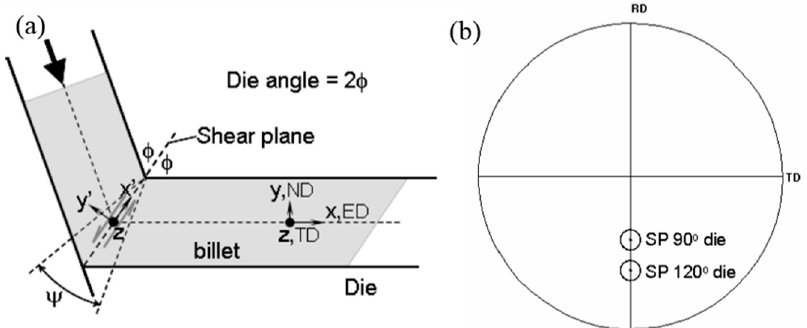
Figure 1. Schematic diagram illustrating ( a ) equal channel angular extrusion (ECAE) process and reference coordinates and ( b ) poles of (111) planes parallel to the dies shear plane in the 90° and 120° dies respectively in the (111) pole figure.